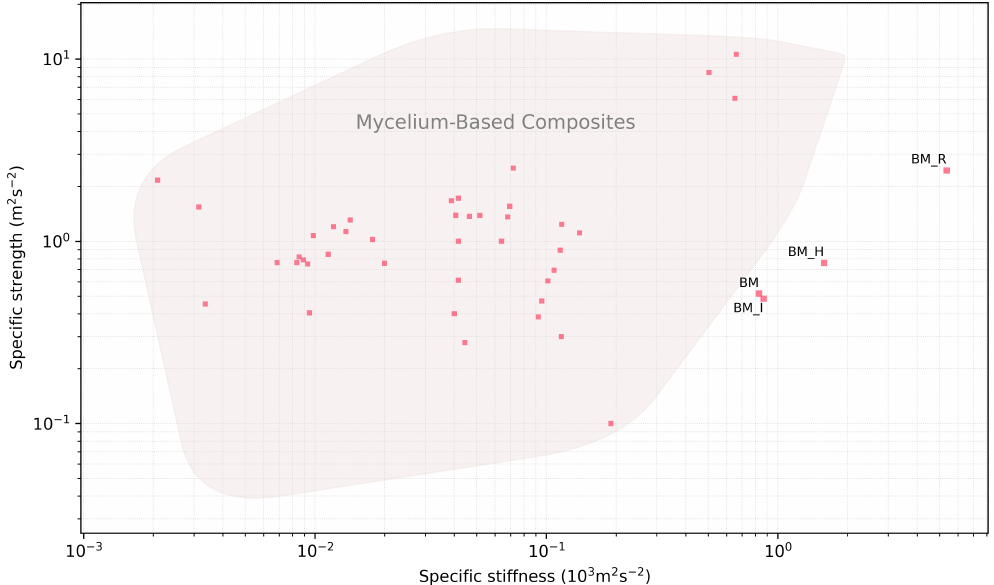
Figure 6. Specific strength results as a function of specific stiffness. Labelled data points: results from this study; unlabelled data points: reports from the